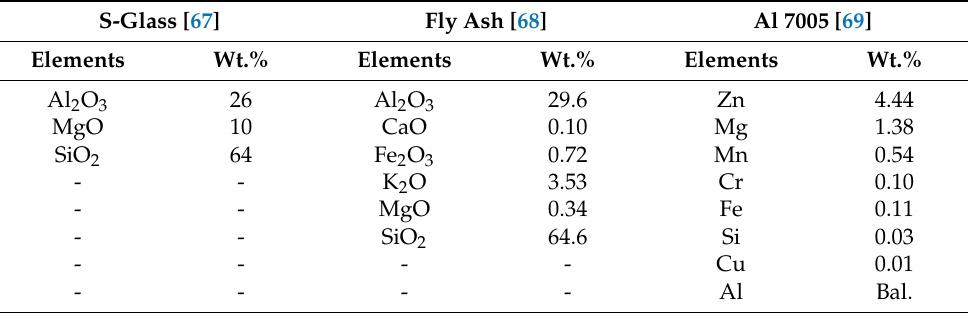
Table 2. Chemical composition of matrix and reinforcement